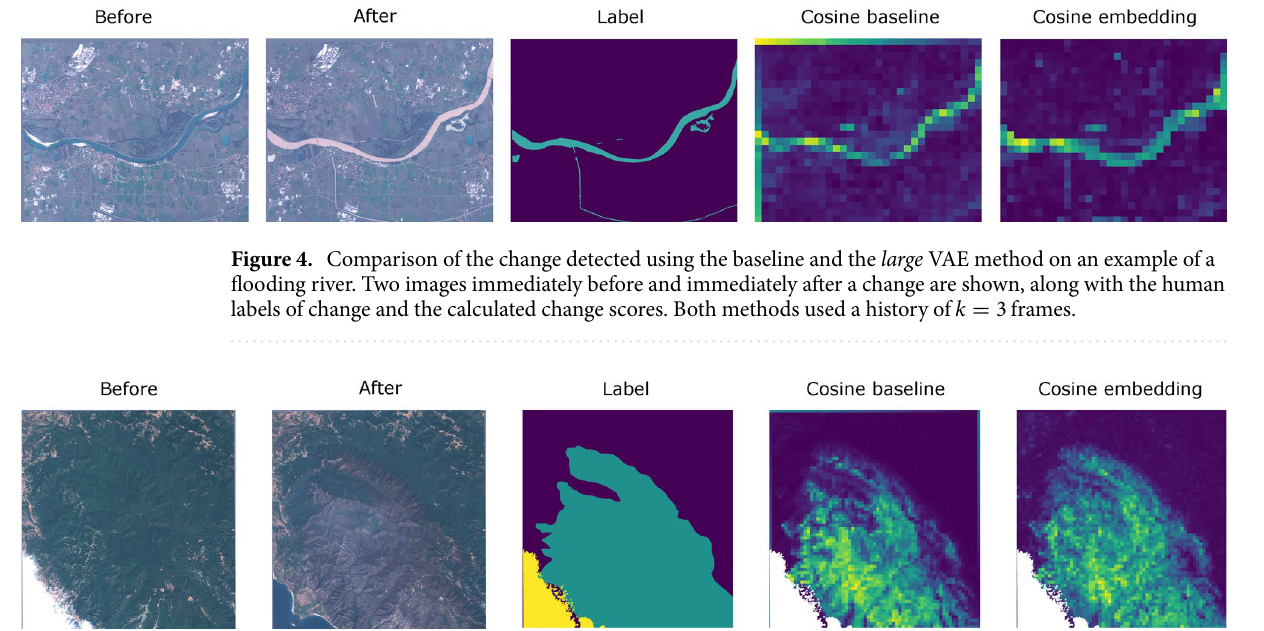
Figure 5. Additional comparison of the change detected using the baseline and the large VAE method on an example of a fire disaster. Both methods used a history of k = 3 frames. The cosine baseline prediction seems to more closely copy the details present in the image, making it susceptible to small, noisy variations between the two